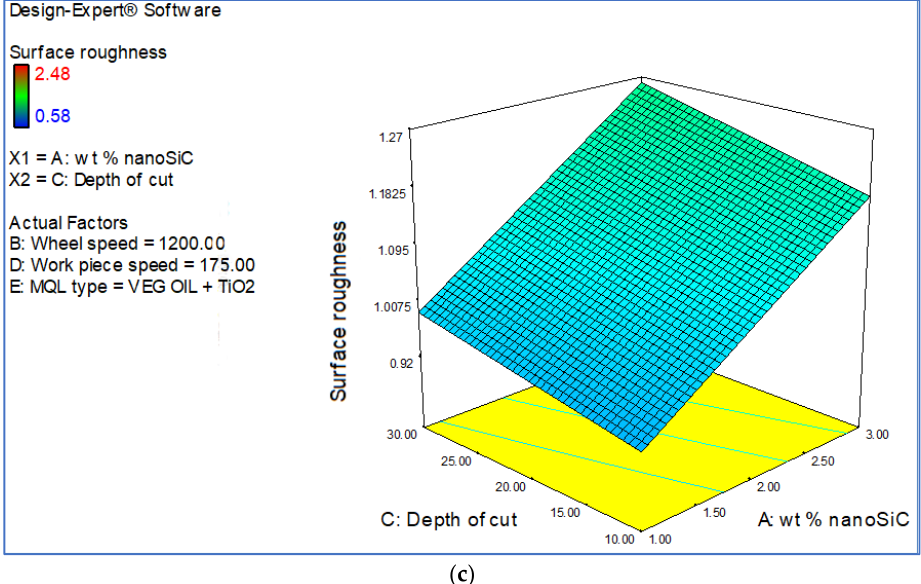
Figure 7. ( a ) 3D response plot for SR on wt % of nano-SiC vs. depth of cut under SAE20W40. ( b ) 3D response plot for SR on wt % of nano-SiC vs. depth of cut under veg oil. ( c ) 3D response plot for SR on wt % of nano-SiC vs. depth of cut under veg oil + TiO 2 .